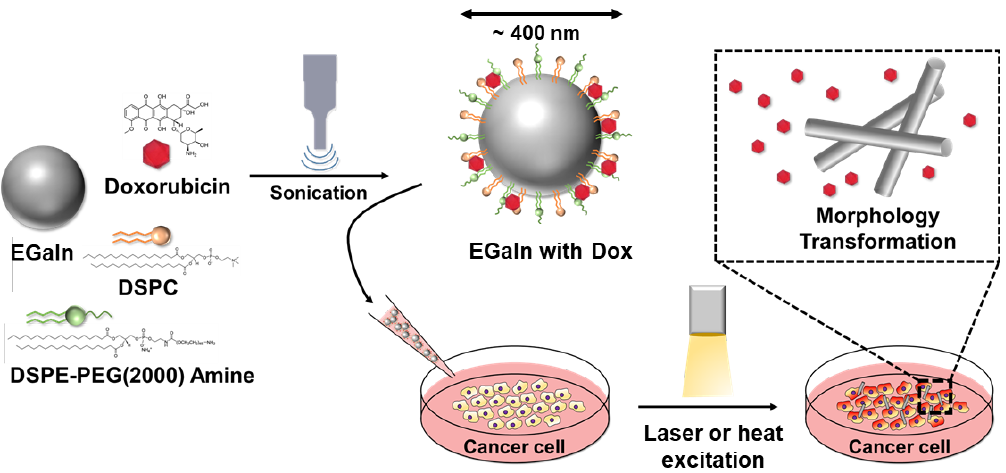
Figure 1. Schematic illustration showing the synthesis of doxorubicin-loaded core-shell liquid metal particles (liquid metal (LM) / 1,2-distearoyl-sn-glycero-3-phosphocholin (DSPC) / doxorubicin (DOX)). particles (liquid metal (LM)/1,2-distearoyl-sn-glycero-3-phosphocholin (DSPC)/doxorubicin (DOX)). DSPE-PEG-2000 Amine, 1,2-distearoyl-sn-glycero-3-phosphoethanolamine-N-[amino (polyethylene DSPE-PEG-2000 Amine, 1,2-distearoyl-sn-glycero-3-phosphoethanolamine-N- [amino (polyethylene glycol)-2000]; EGaIn, eutectic glycol) -2000]; EGaIn, eutectic gallium–indium.